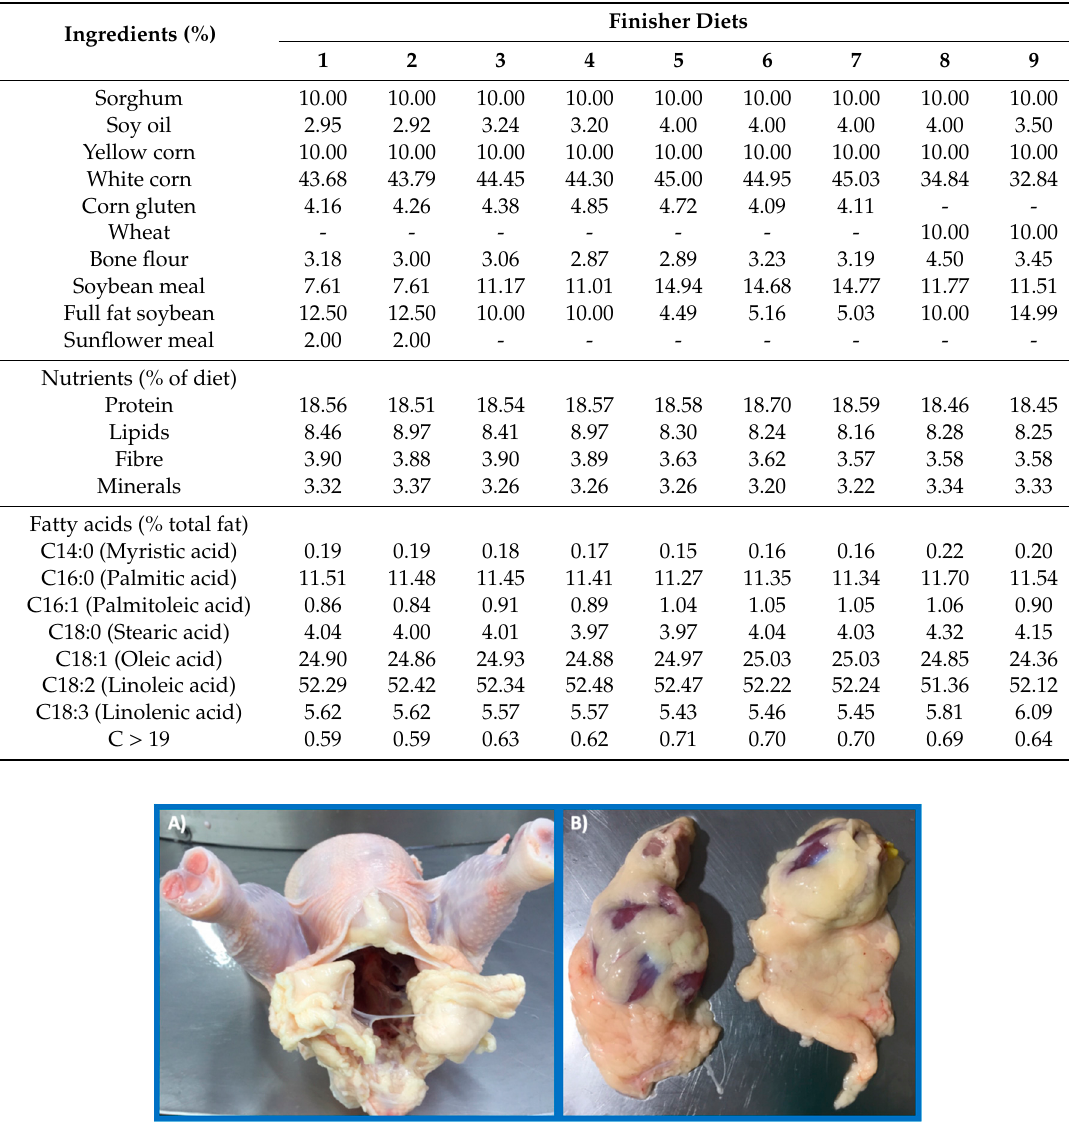
Table 1. Experimental finisher diets.